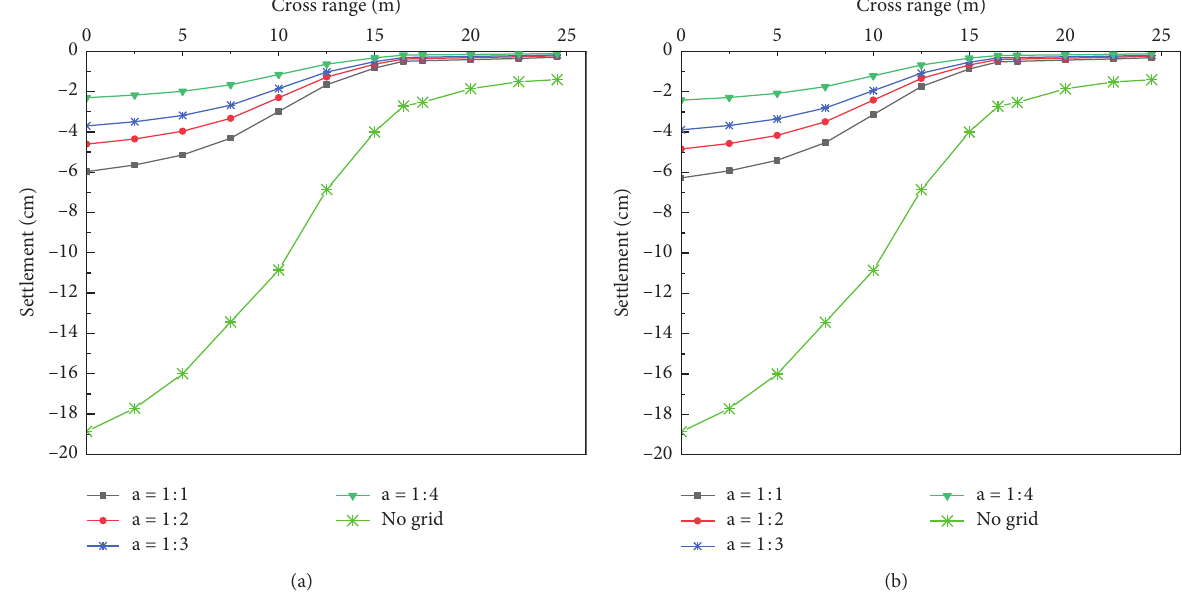
Figure 9: Settlement of the top surface of the subgrade at different grid laying lengths. (a) Full-laying grille with a subgrade depth below 5m. (b) Sublaying grille with a subgrade depth below 5m.